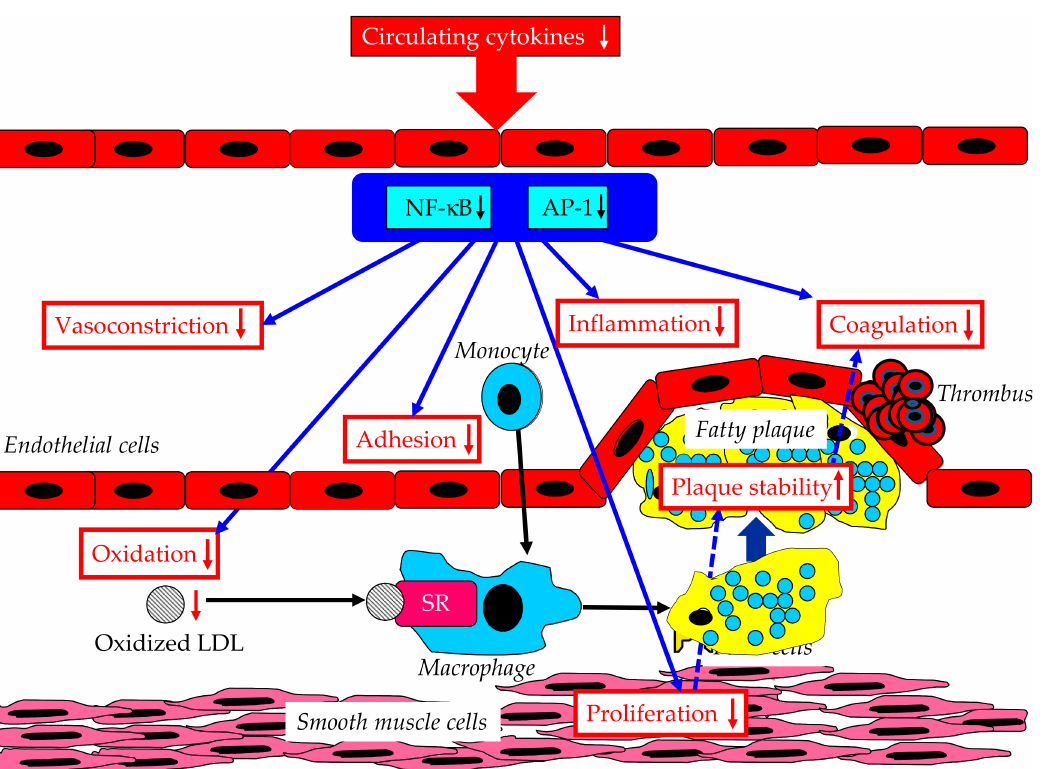
Figure 6. Beneficial effects of PPAR α agonists on vascular integrity. AP-1, activator protein 1; NF- κ B, nuclear factor kappa B; SR, scavenger